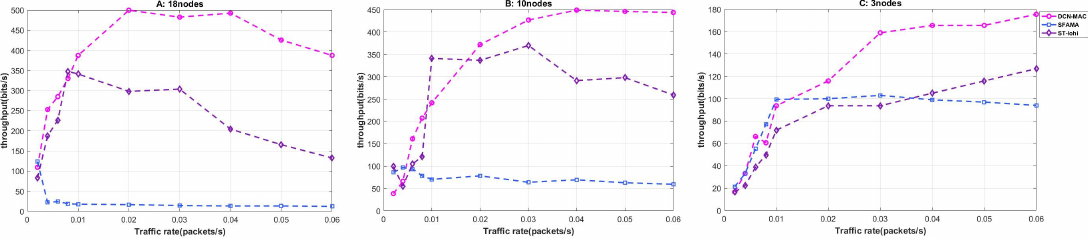
Figure 6. The throughput of the network at different packet generation rates when the number of nodes was 3, 10, and